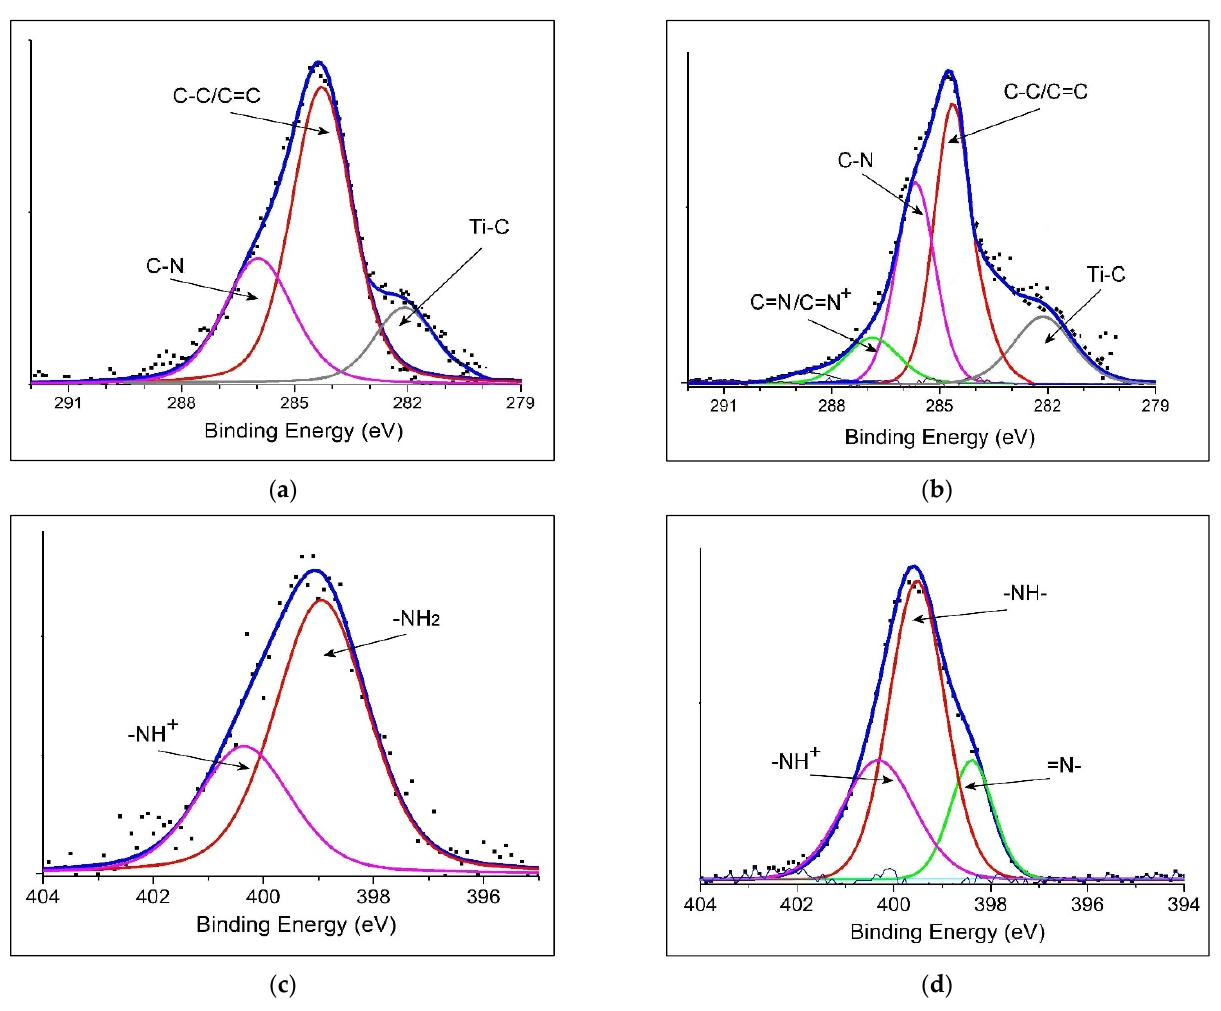
Figure 3. XPS spectral: ( a ) C1s of PANI@TiC; ( b ) C1s of PANI@TiO 2 –TiC; ( c ) N1s of PANI@TiC; and ( d ) N1s of PANI@TiO 2 –TiC. Table 2. The atomic percentage (%) of synthesized hybrid materials.